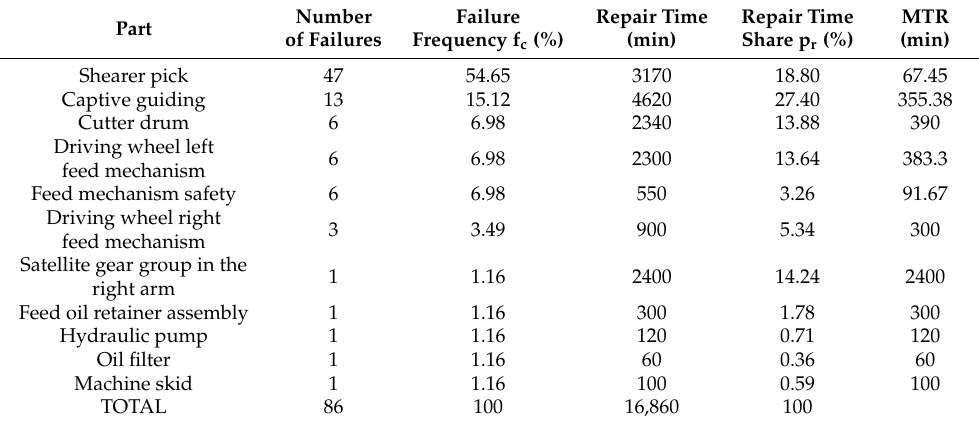
Table 5. The centralizer of the failures and repair times for the KSW-460NE shearer machine. Number Failure Part of Failures Frequency f c